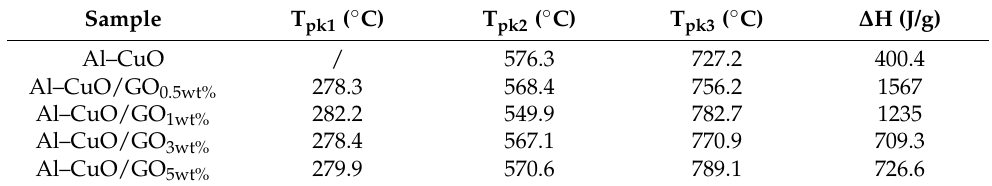
Figure 7. DSC results of composites with 0.5 wt%, 1.0 wt%, 3.0 wt%, and 5.0 wt% of GO at a heating rate of 10 °C/min. Table 2. DSC parameters of Al–CuO/GO with 0 wt%, 0.5 wt%, 1.0 wt%, 3.0 wt%, and 5.0 wt% of GO.